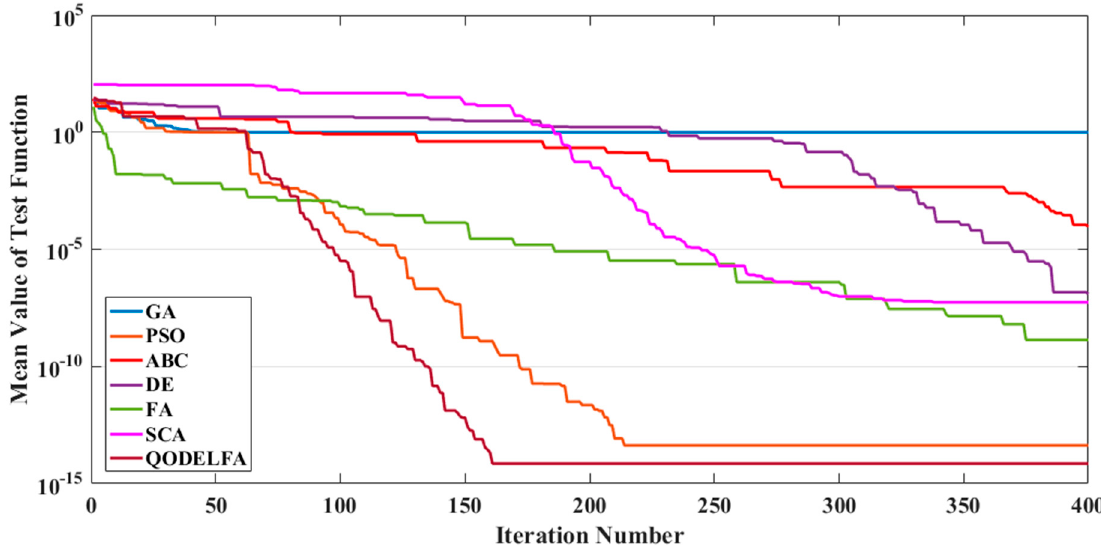
Figure 2. Convergence characteristics for Rastrigin function.